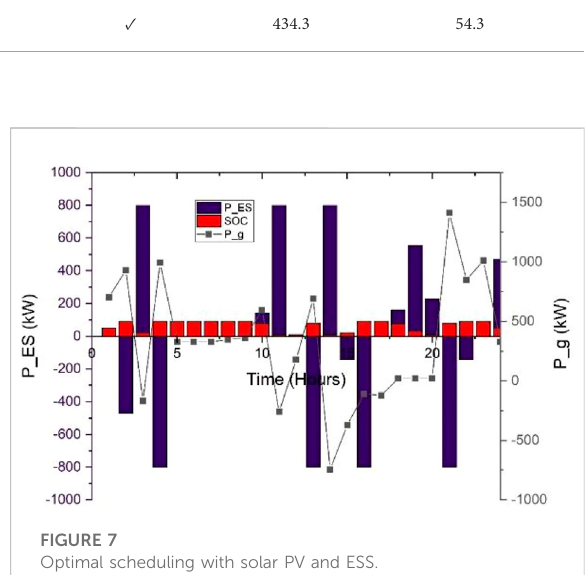
FIGURE 7 Optimal scheduling with solar PV and